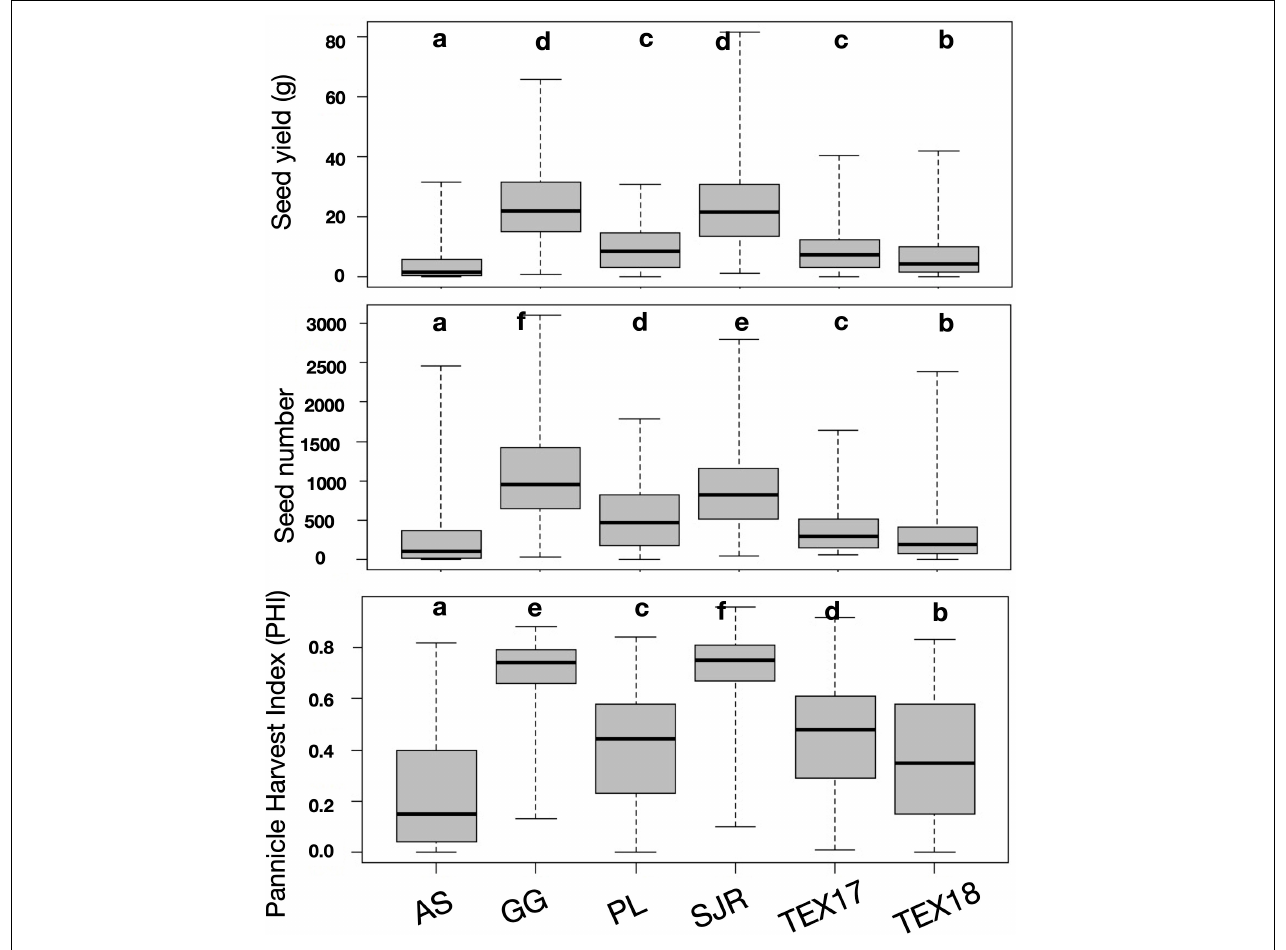
FIGURE 1 | Boxplots showing the variation for the traits seed yield, seed number and panicle harvest index (PHI) across the different environments. Denotation with different letters indicates significant differences as revealed by a Student-Newman-Keuls (SNK) Post hoc -Test ( α = 0.05). TABLE 3 | Pearson’s correlation coefficient ( r ) among the traits seed yield (SY), seed number (SN), panicle harvest index (PHI), thousand kernel weight (TKW), and plant height (PH) across the different environmental groups [stress environments: Poel (PL), Asendorf (AS), Texcoco 2017 (TEX17), Texcoco 2018 (TEX18);